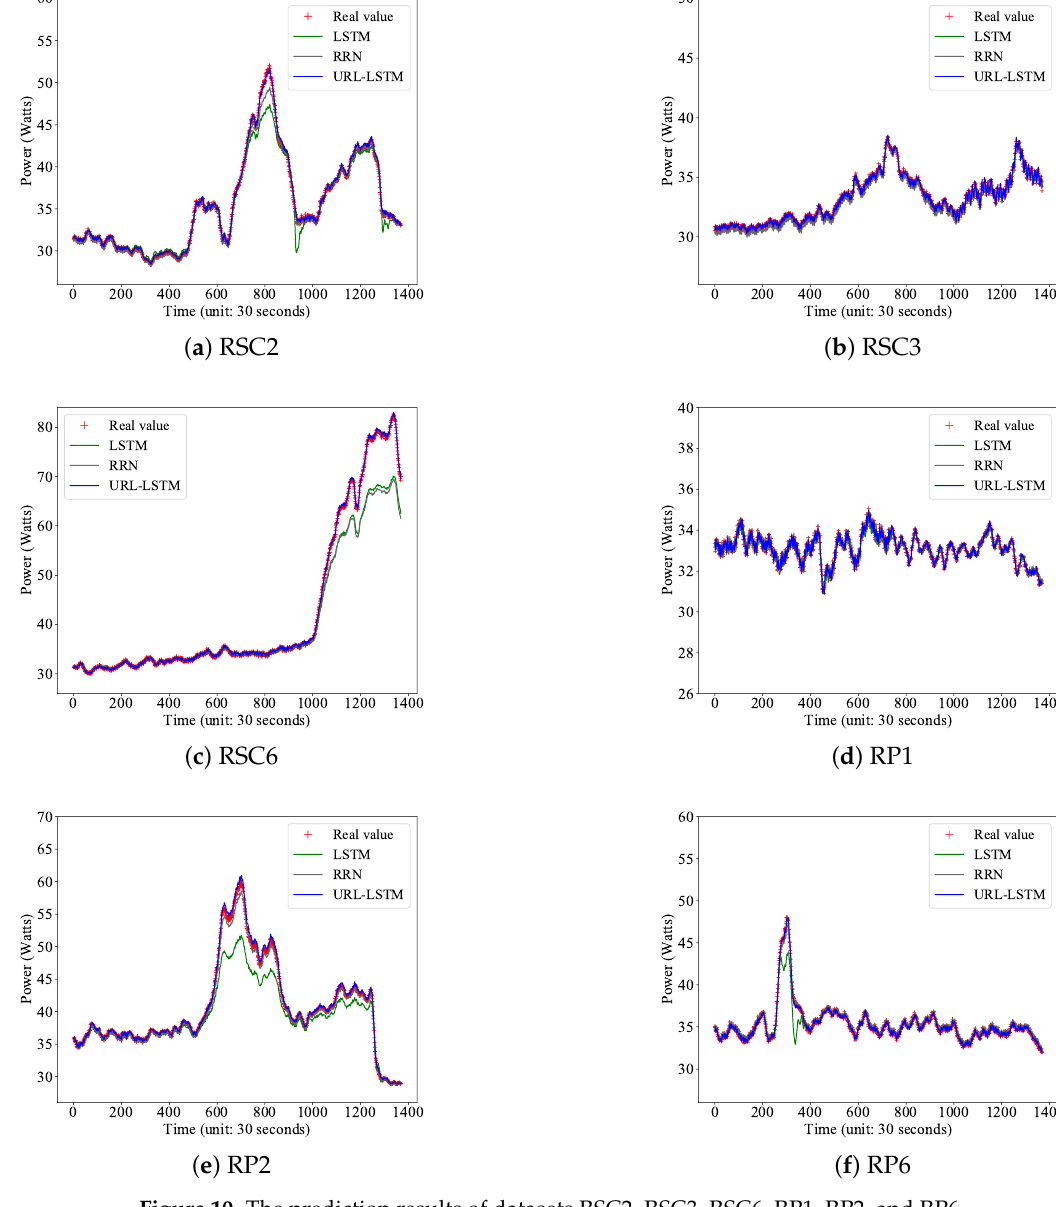
Figure 10. The prediction results of datasets RSC2, RSC3, RSC6, RP1, RP2, and